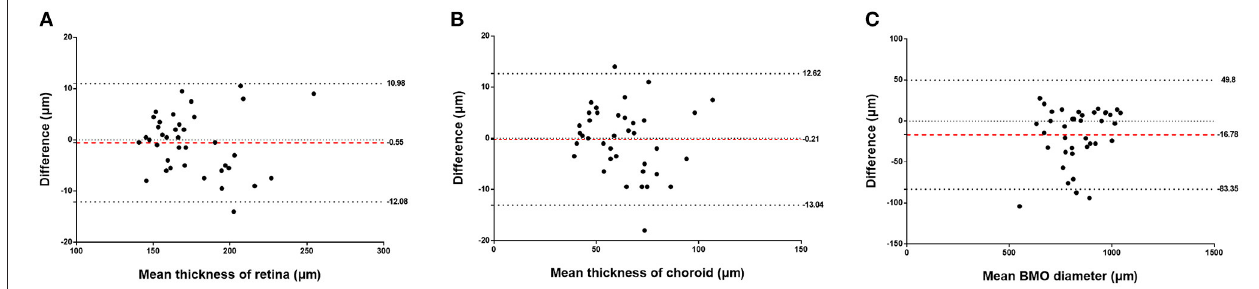
FIGURE 4 | Bland-Altman analysis showing the inter-observer repeatability for measurements of the retinal thickness (A) , choroidal thickness (B) , and Bruch’s membrane opening (BMO) diameter (C) . Red dotted line: mean bias, thick dotted lines: upper and lower limit of agreement, thin dotted line: baseline (zero).